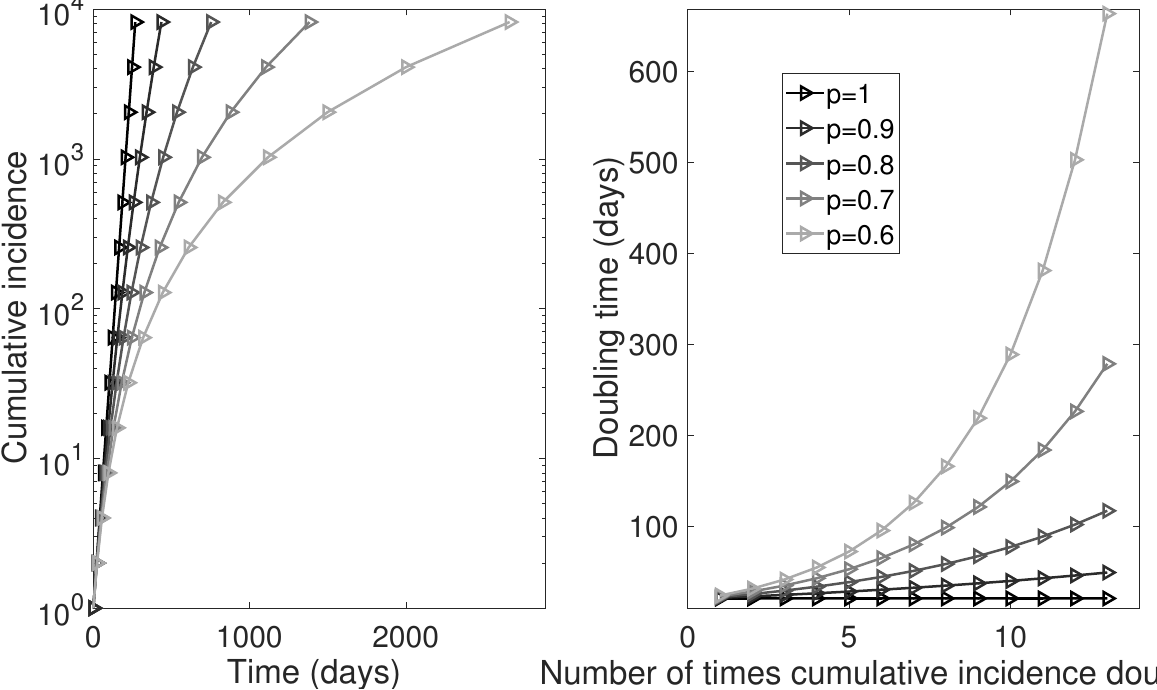
Figure 2. The cumulative incidence and the sequence of “doubling times” for the growth dynamics dynamics obtained from the generalized-growth model with varying levels of epidemic growth scaling parameter, p